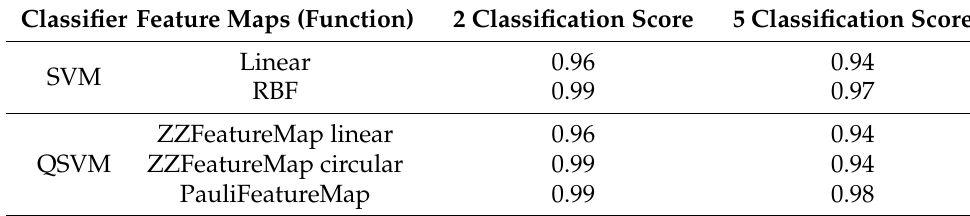
Table 5. Comparison of accuracy between quantum and classical classifiers using different cod- ing methods.